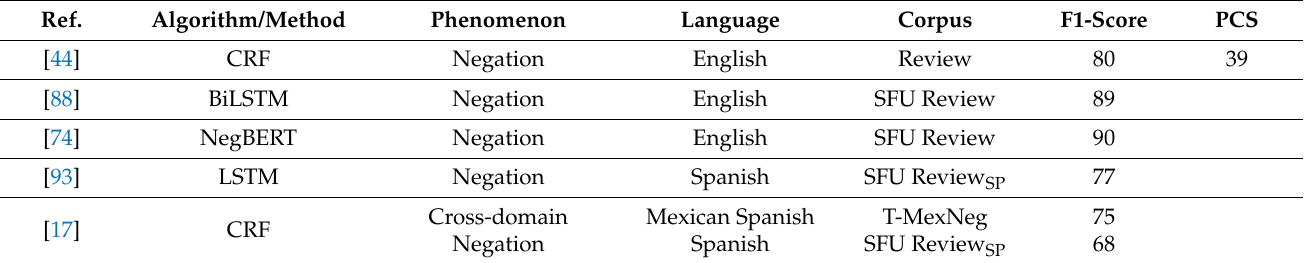
Table 4. Negation detection systems in the review